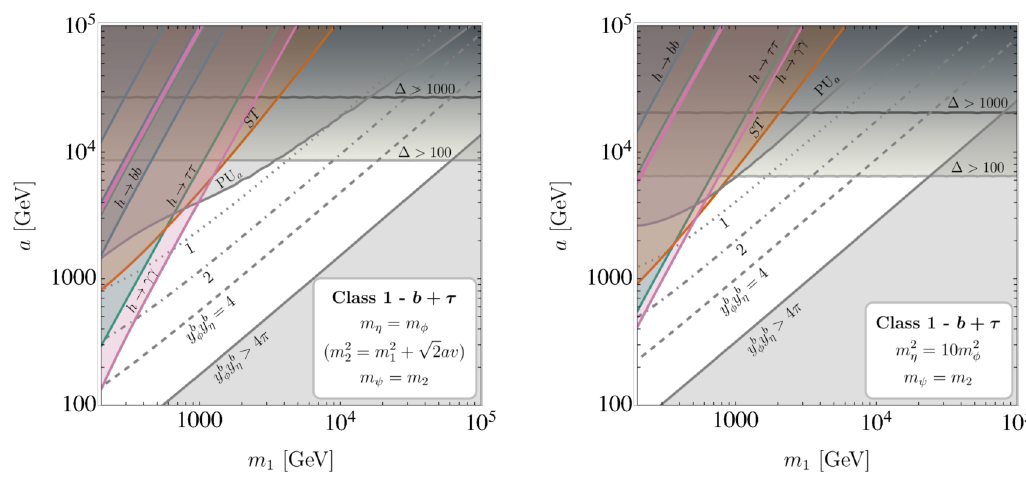
Figure 7. Theoretical (grey) and current 2 σ experimental constraints (coloured) on the Class 1 combined b + τ benchmark